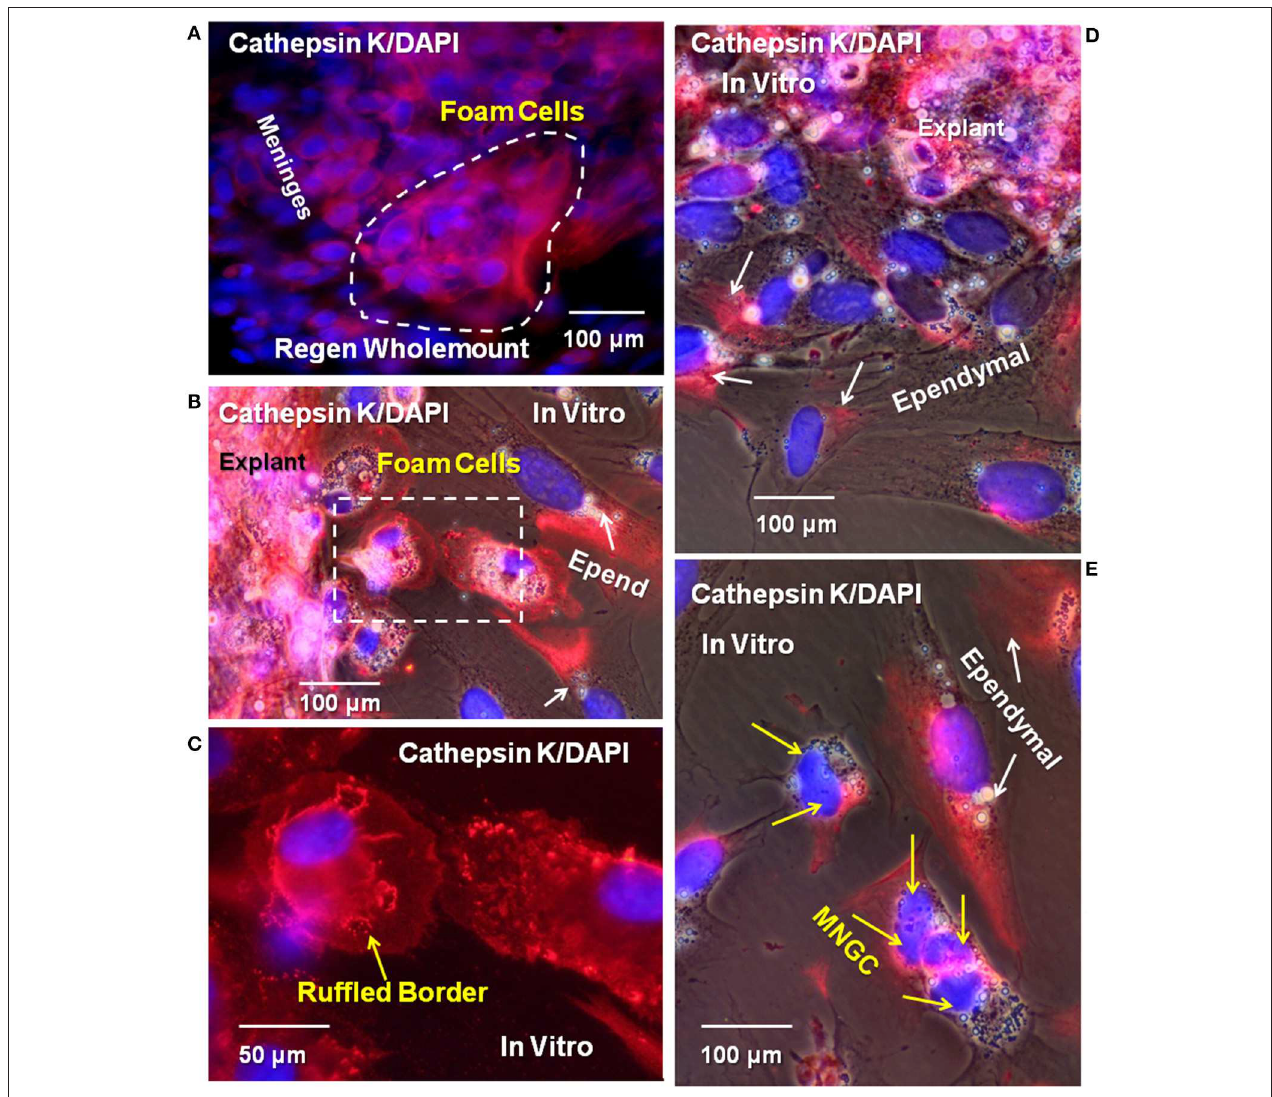
FIGURE 11 | Cysteine protease cathepsin K was detected in meninges, ependymal cells, foamy macrophages, and MNGCs in vitro and in vivo . (A) Wholemount cord tissue from 16D regenerating cord were co-labeled for cathepsin K (red) and DAPI (blue). Cells on the surface of the meninges are positive for cathepsin K (dashed white line). Explants from 16D regenerate cord, cultured for 10DIV, showed labeled ependymal cells (B,D,E) , foamy macrophages ( B , dashed square), and an MNGC (E) . Yellow arrows indicate foam cells, white arrows indicate ependymal cells. Ruffled borders sequestering cathepsin K between foam cells and the culture substratum were also detected (yellow arrow, C ). Yellow arrows indicate nuclei in MNGCs positive for cathepsin K in (E) . Regen, regenerating; D, day; DIV, days in vitro ; MNGC, multinucleated giant cells. Magnification bar is shown in the lower portion of the